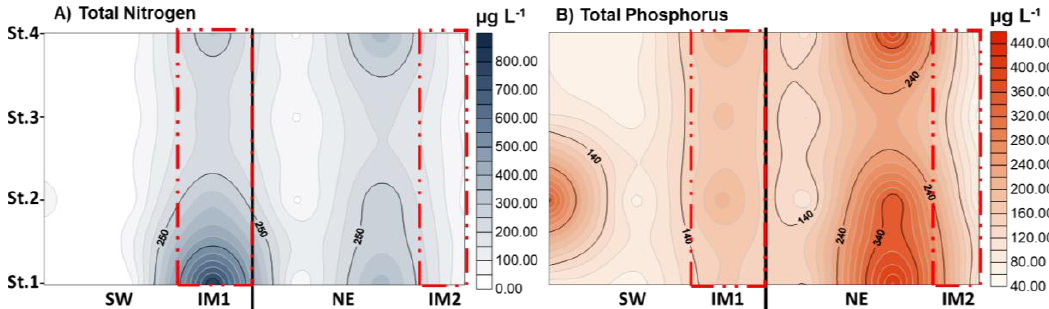
Figure 9. Seasonal changes of nutrients, ( A ) total nitrogen and ( B ) total phosphorus at different sites in the Sangga Kechil estuarine-mangrove area during the study period. Table 2. Percentages and nutrient ratios (TN:TP) based on Redfield ratio 16:1 contrasting phytoplankton communities between monsoonal seasons in the Sangga Kechil estuarine-mangrove area.